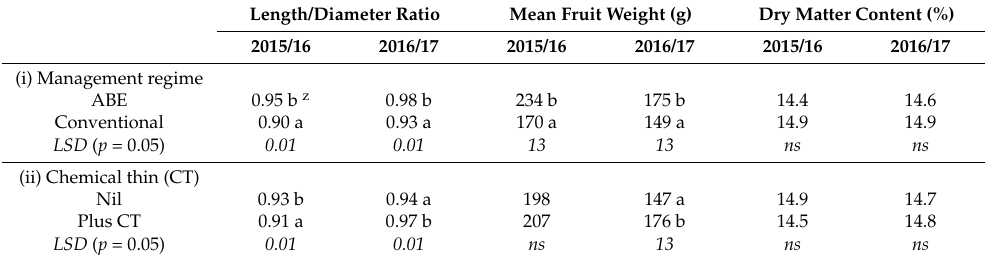
Table 10. Effect of management regime and thinning method on fruit shape, weight and dry matter content of ‘Alvina Gala’ (Trial 2). ABE = artificial bud extinction.